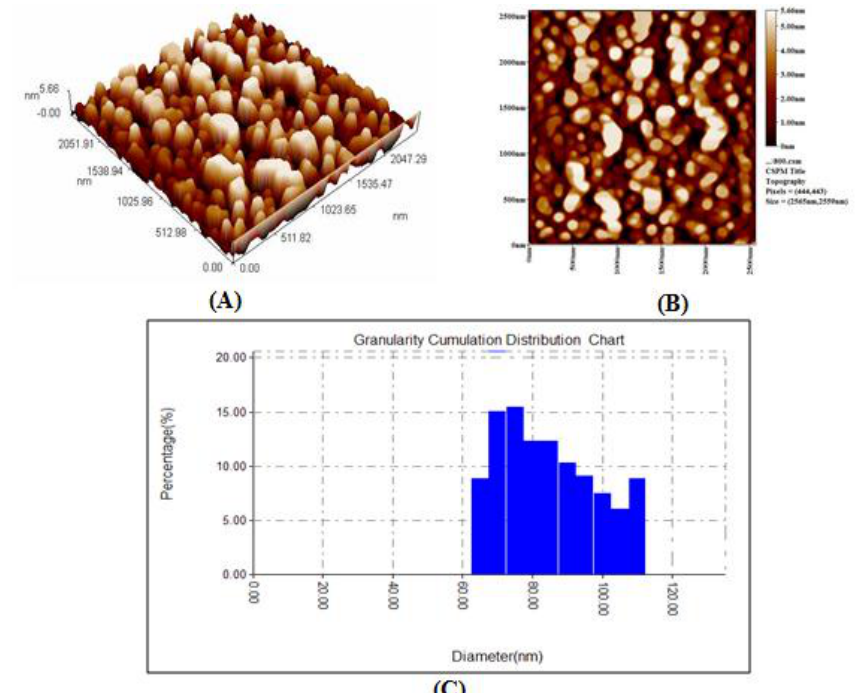
Fig. 8: AFM images (a) 3D and in (b) 2D and (c) Granularity accumulation distribution chart of the S2